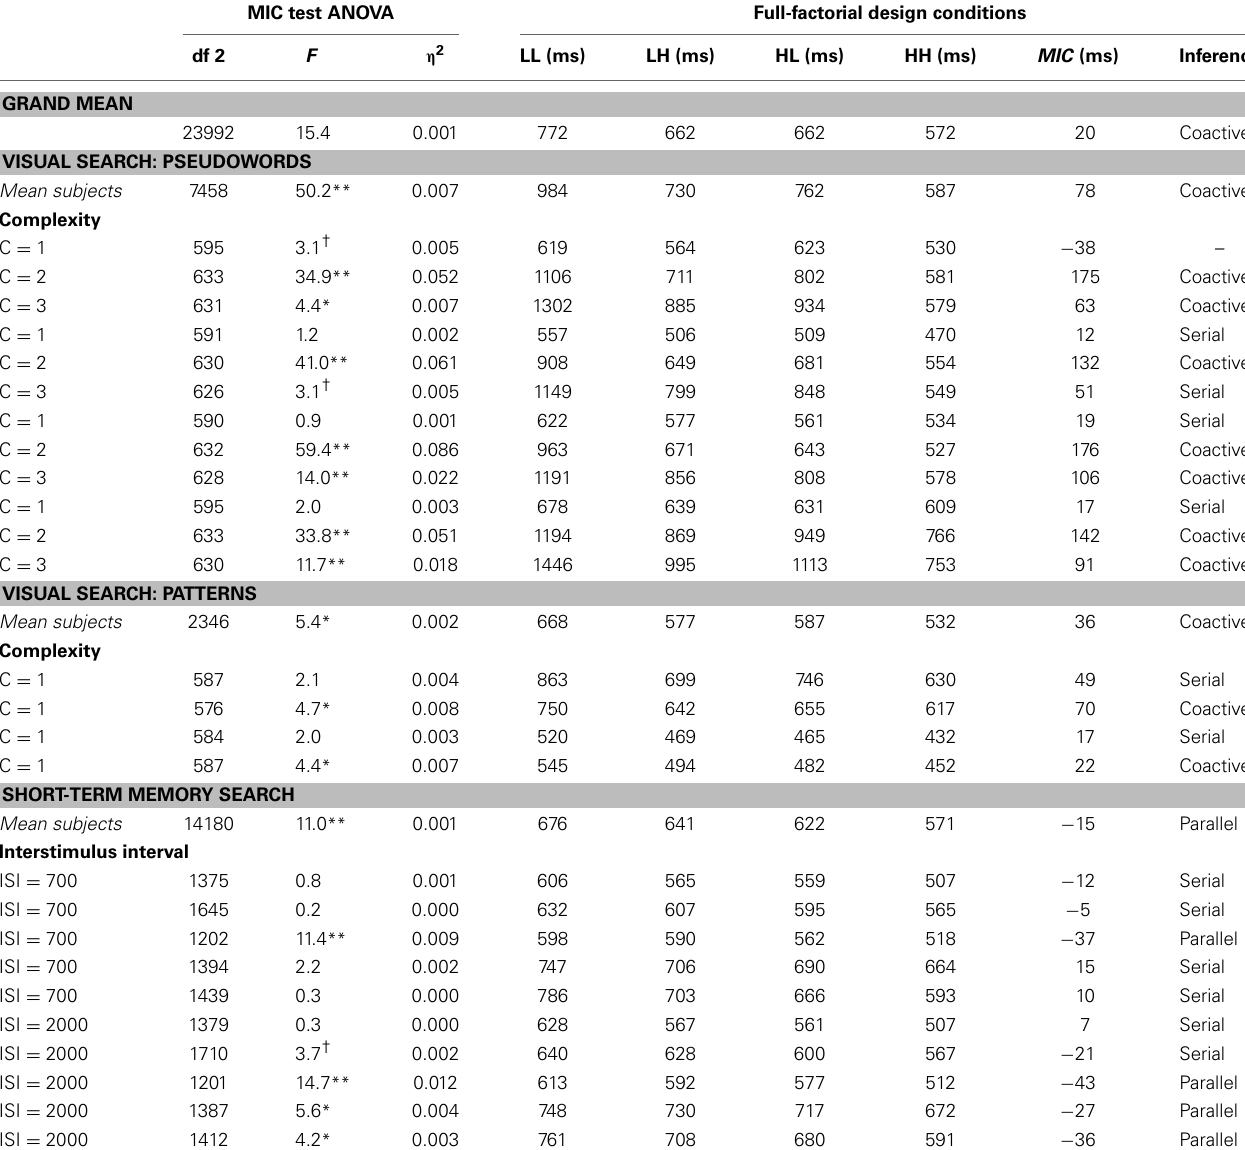
Table 2 | Summarized ANOVA results for the MIC tests at different levels of subject